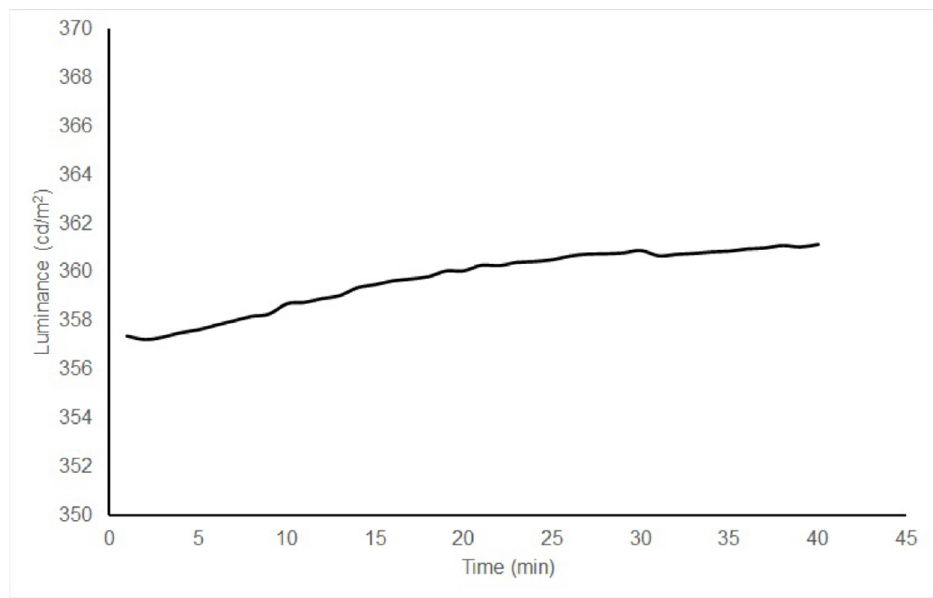
Figure 2. Luminance response curve over time for a randomly selected tablet. Luminance increases more rapidly in the initial minutes and reaches a variation of less than 1 cd/m 2 20 min after switching on the